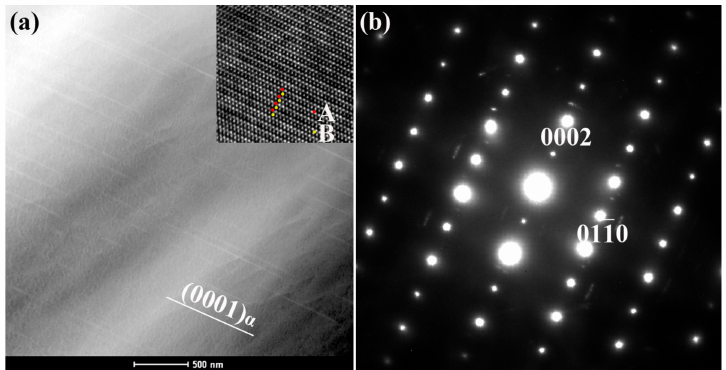
Figure 3. ( a ) High-angle annular dark-field (HAADF) image of the sample aged for 18 h, and the corresponding HRTEM image; and ( b ) SAED pattern taken along